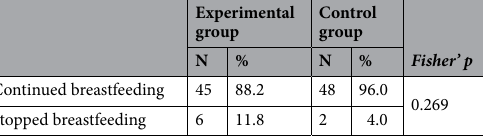
Table 4. Between-group comparison of the breastfeeding rate on day-5 of treatment.